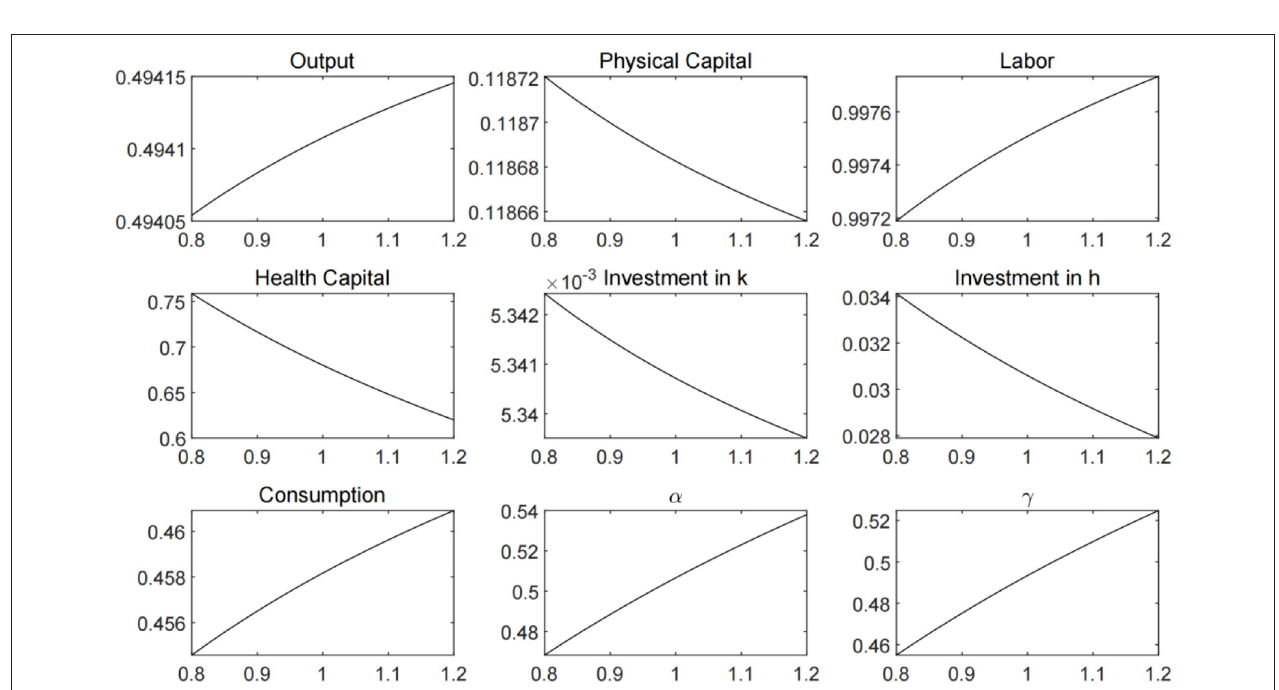
FIGURE 4 | Economic steady states under different ζ values.